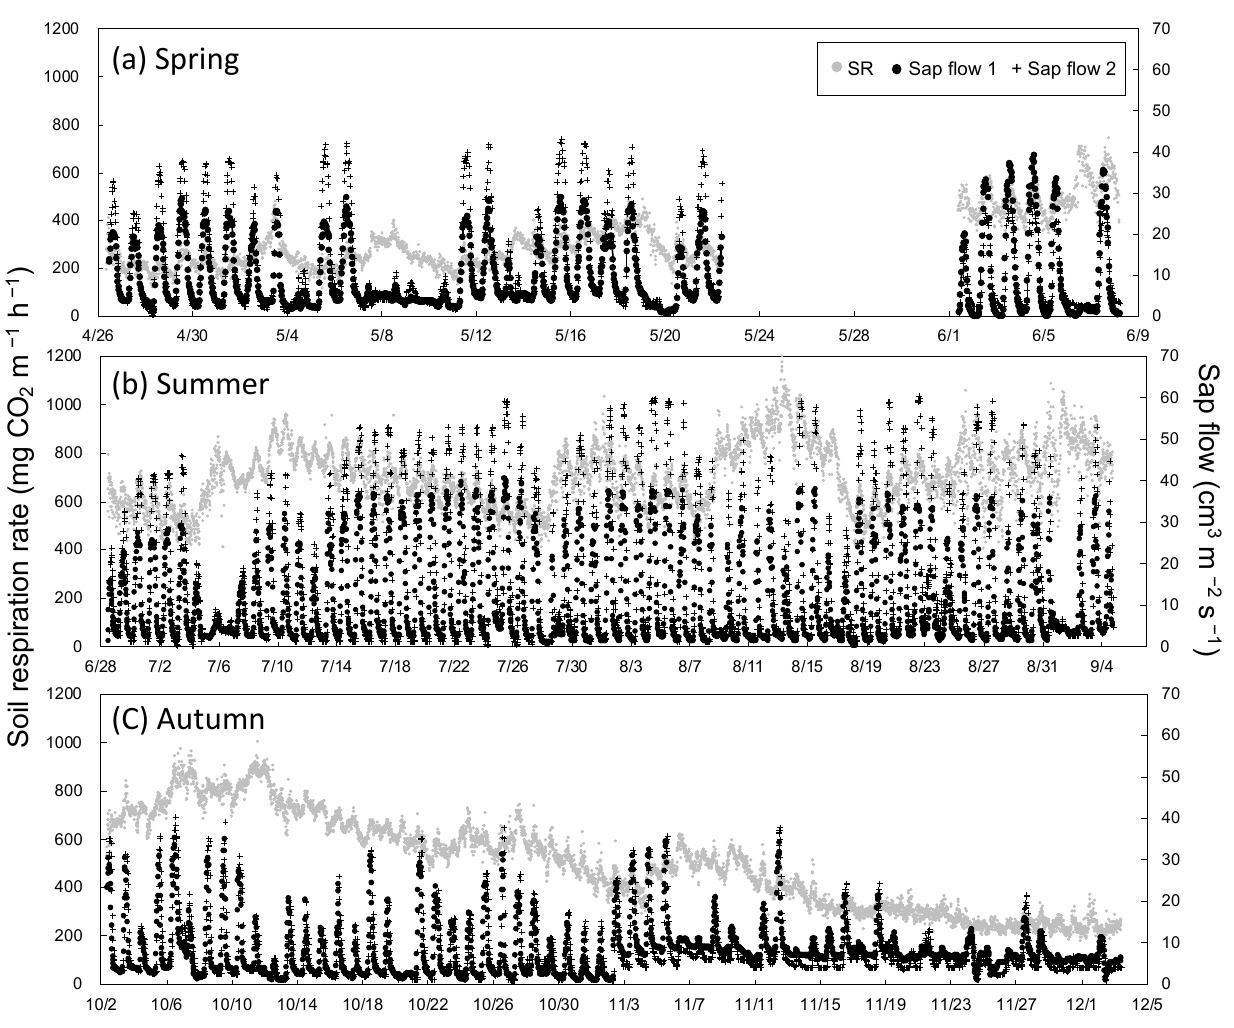
Figure 5. Temporal variation in soil respiration (chamber 1) and two sap flows in ( a ) spring, ( b ) summer, and ( c ) autumn in 2018.